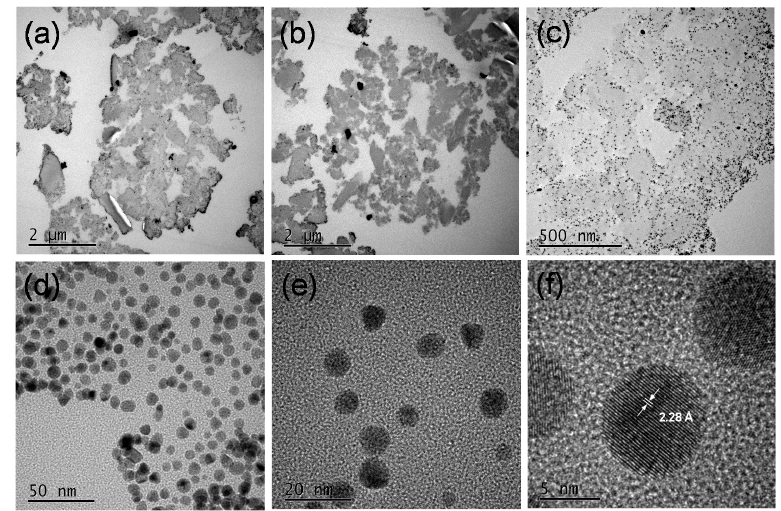
Figure 6. TEM images of the ultra-microtomed sections of AuNP-WP sample from 0.6 mM of Au ions at different magnifications.